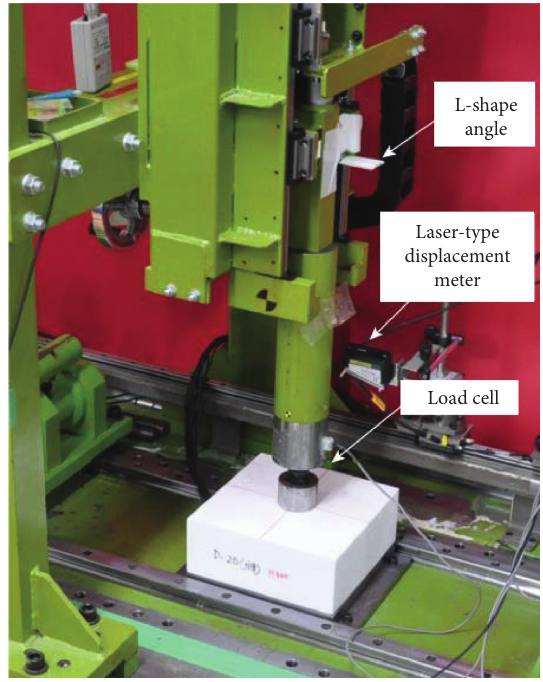
Figure 4: State of the falling-weight impact-loading test.